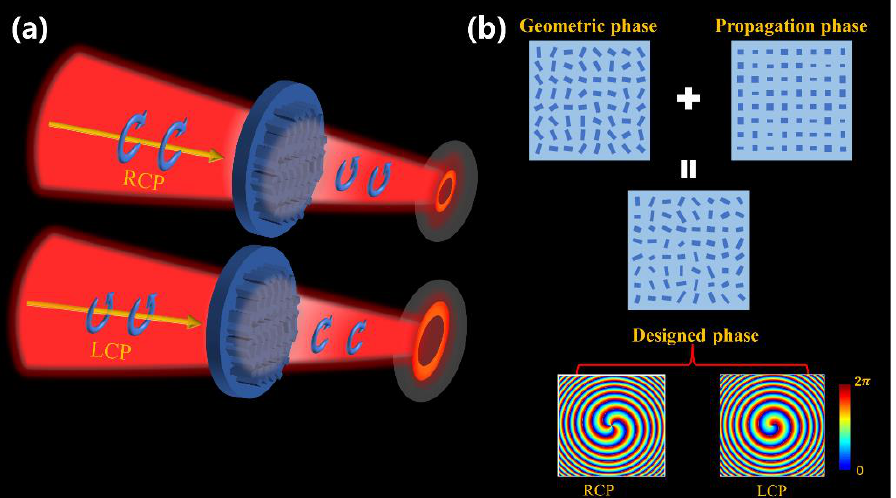
Figure 3. Generation of spin-decoupled PVBs. ( a ) Schematic of the spin-decoupled metasurface. ( b ) The designed total phase of the single-layer metasurface simultaneously contains the geometric phase and the dynamic phase, which are only related to geometry parameters and the rotation angle of the unit structure, respectively.